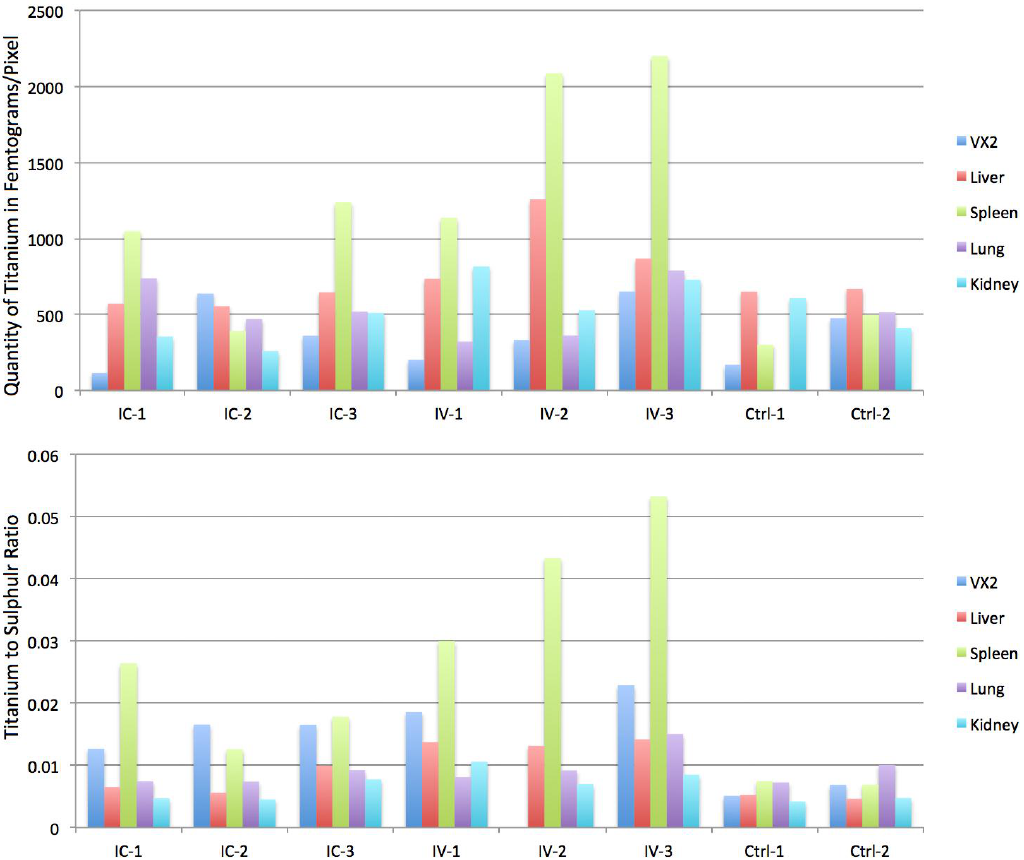
Figure 6. Graphic representation of data in Table 1. ( Top ) Ti concentration (in femtograms per pixel) in different tissues from nanoparticle treated animals and controls; data for each animal are shown. ( Bottom ) Mean ratio of Ti (femtograms) vs. S (femtograms) per pixel; please note that data structure allows comparison on a per pixel basis. Thus, information provided by the bottom graph allows us to monitor the situation most accurately, e.g., if tissue integrity is uneven, resultant uneven concentration of nanoparticles in tissue will not be misinterpreted. Likewise, false background (“salt and pepper” signal pattern for Ti) is effectively removed when false signals are divided by real signal for S.